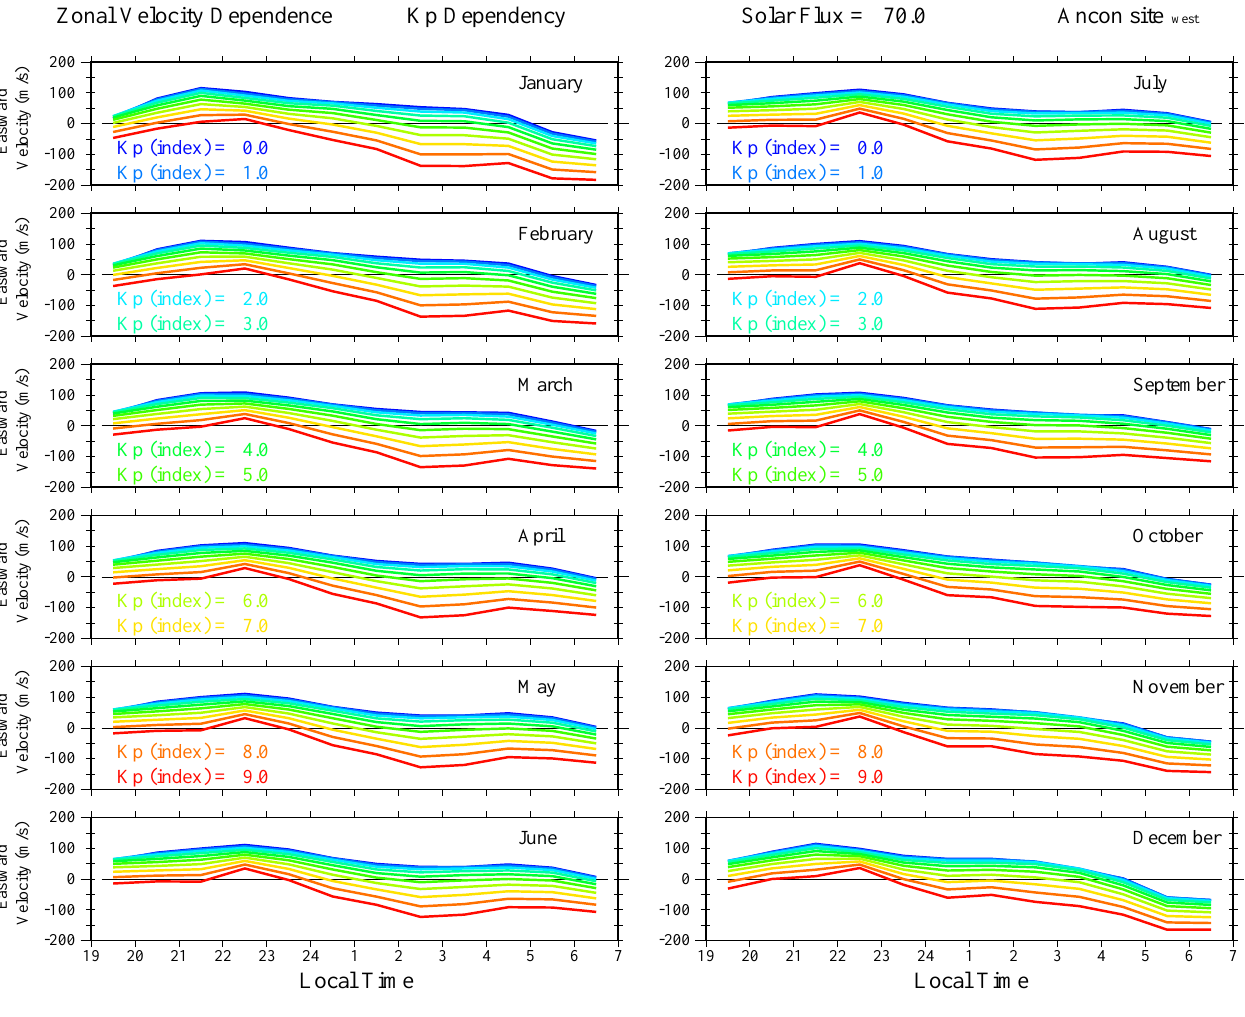
Fig. 6. (a) Ancon zonal drift dependence on K p , solar